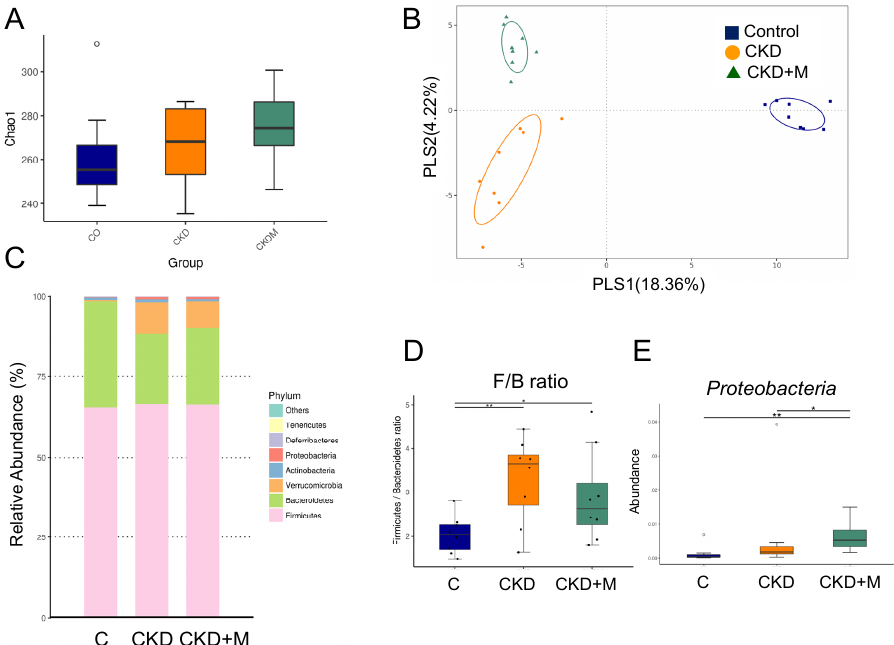
Figure 3. Gut microbiota composition in female rats. ( A ) α -diversity represented by Chao1 analysis, ( B ) β -diversity measured by partial least squares discriminant analysis (PLS-DA), ( C ) relative abun- dance of the top phyla of the gut microbiota among the three groups, ( D ) the Firmicutes to Bacteroidetes ratio, and ( E ) the abundance of the phylum Proteobacteria among the three groups. N = 8/group. Data are shown as means ± SD. The single asterisk indicates p < 0.05 vs. C. The double asterisk indicates p < 0.01 vs. C.